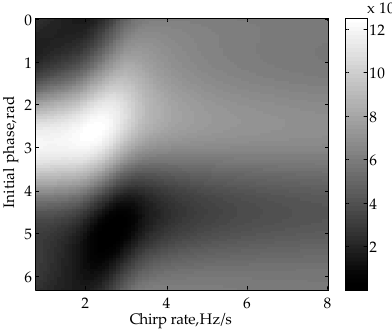
Figure 10. Mean square error distribution in parameter estimation.